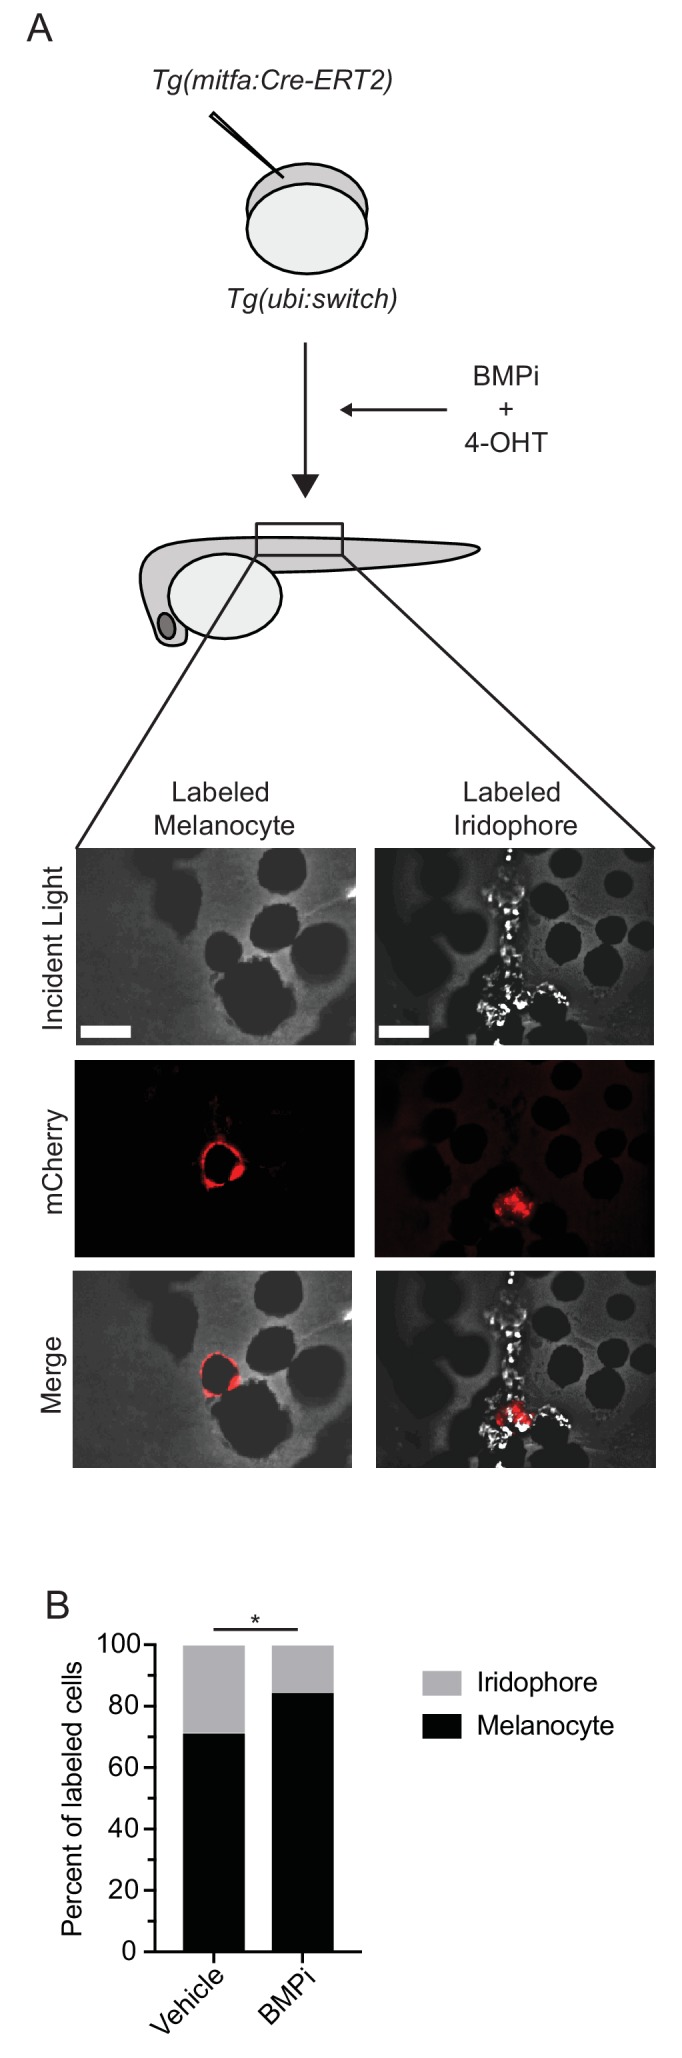
BMP inhibition impacts fate specification of mitfa-positive pigment progenitor cells.(A) Diagram of lineage tracing experiment. Embryos containing Tg(ubi:switch) were injected with a mitfa:Cre-ERT2 construct and treated with BMPi and tamoxifen (4-OHT) from 12 to 24 HPF to block BMP signaling and allow Cre recombination. At 5 DPF, animals were screened for successful recombination by presence of single mCherry-labeled pigment cells, and the identities of those cells were assessed using incident light. Scale bar = 40 µm. (B) Quantification of mCherry-labeled cell fates at 5 DPF in vehicle and BMPi-treated animals, n = 101 and 80 labeled cells for vehicle and BMPi groups, respectively, from five independent experiments (N = 5); P-value calculated using Fisher’s exact test, *p<0.05.Figure 6—source data 1.BMP inhibition impacts fate specification of mitfa-positive pigment progenitor cells.